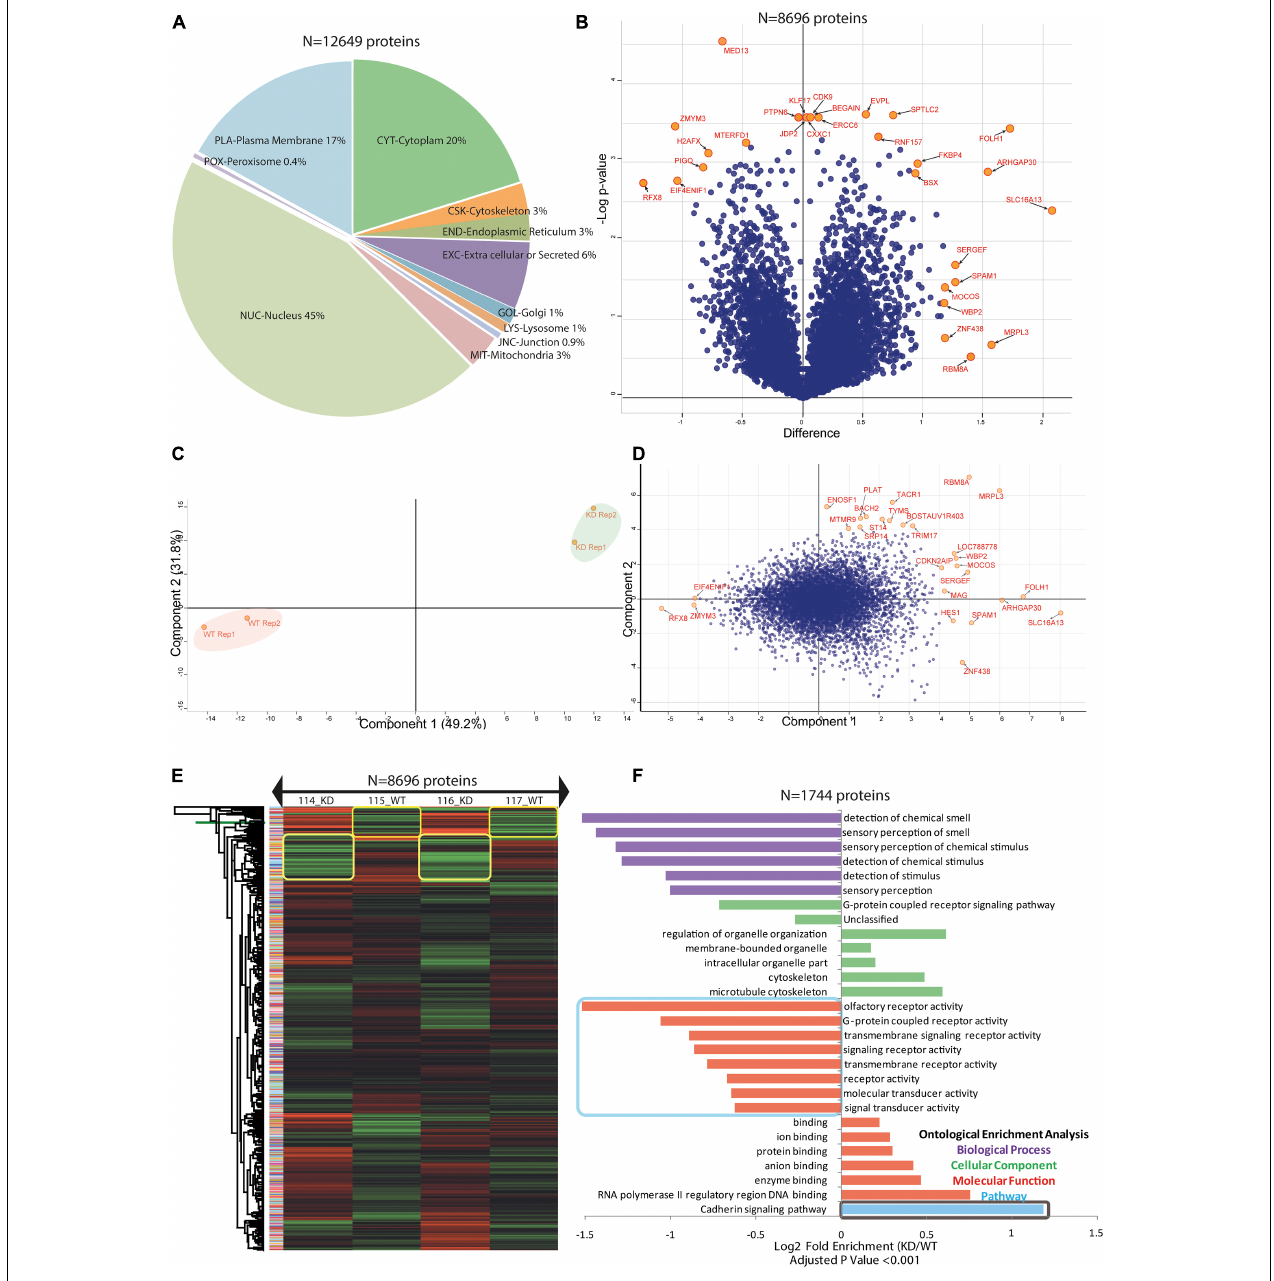
FIGURE 4 | BuMEC in-depth proteome analysis. (A) A pie chart shows the different percentage of occupancy of the identified proteome in compartmental based localization of epithelial cells. See also Supplementary Table 5 . (B) Volcano plot shows the significantly differentially expressed proteins and extremely affected proteins were labeled with the orange color circle with named in red color. The two-sided t -test was calculated using artificial within-group variance S0 equals zero. Further truncation was performed using a permutation based FDR equals 0.01, and the number of randomizations equals 250. The X -axis is the t -test difference values while the Y -axis is –log of adjusted p -values. For detailed data, see also Supplementary Table 1 . (C) Principal component analysis shows the proteome data isolation of the components of different iTRAQ labels for biological duplicates samples. Highlighted color reflects the replicate groups; the red color is for wild type cells (WT), and green color is for knockdown cells (KD). (D) The biplot of PCA shows proteome data for comparison of component 1 ( X -axis) to component 2 ( Y -axis) for WT and KD cells in differentially identified proteins. Blue dots that are closely associated are highly correlated in terms of the observed proteome, and extremely isolated orange circles are separated proteins from PC1 and PC2 and were labeled as red color. (E) Heat map presentation of a hierarchical cluster of all 8696 proteins that show significantly different ( p ≤ 0.05) relative abundances in WT versus KD cells. The green color depicts low while red color depicts high expression levels. (F) Protein ontologies enrichment analysis is shown in the form of a bar graph. Biological process (BP), cellular component (CC), molecular functions (MF), and pathways were color-coded with bars. All the enriched values were log 2 transformed, and the adjusted p -values used as < 0.001. For all groups, the overall number of fold enrichment is shown in comparison to the reference database, and detailed information is provided in Supplementary Table 1 .